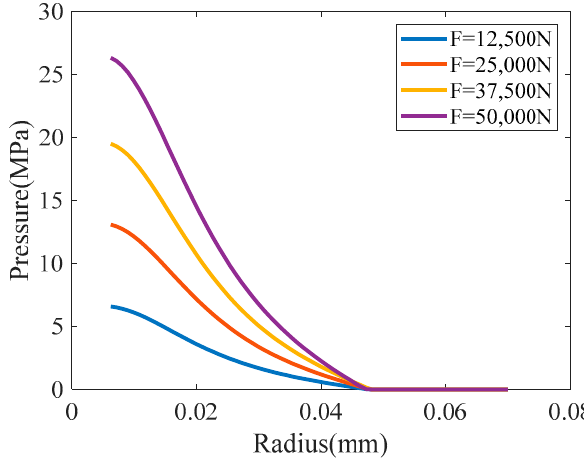
Figure 5. Contact pressure distribution under different tightening forces.